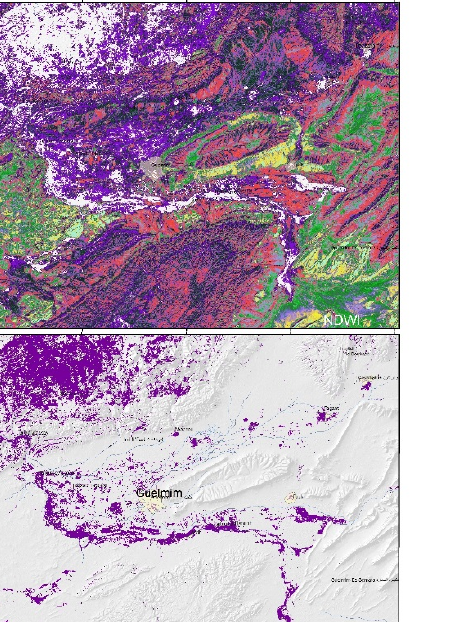
Figure 13. Landsat 8 principal component image showing recent debris flow and sediments in blue-violet colors (acquisition time: 9 December 2014) and corresponding NDWI-water index image indicating in white the highest NDWI values (lower image).